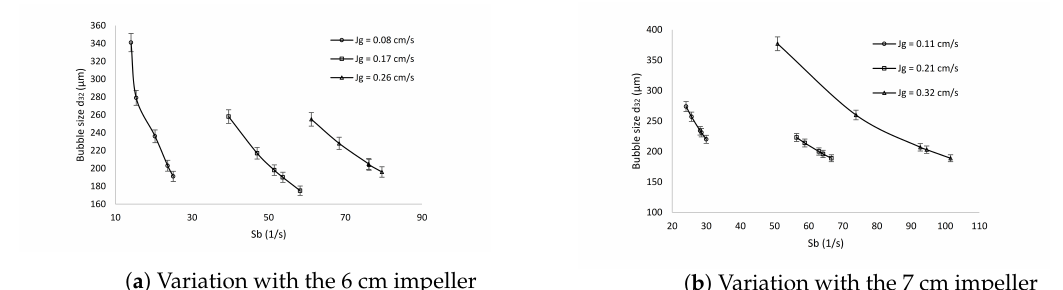
Figure 10. Variation of the bubble size distribution against the bubble surface area flux where ( a ) shows the variation with 6 cm impeller and ( b ) shows variation with 7 cm